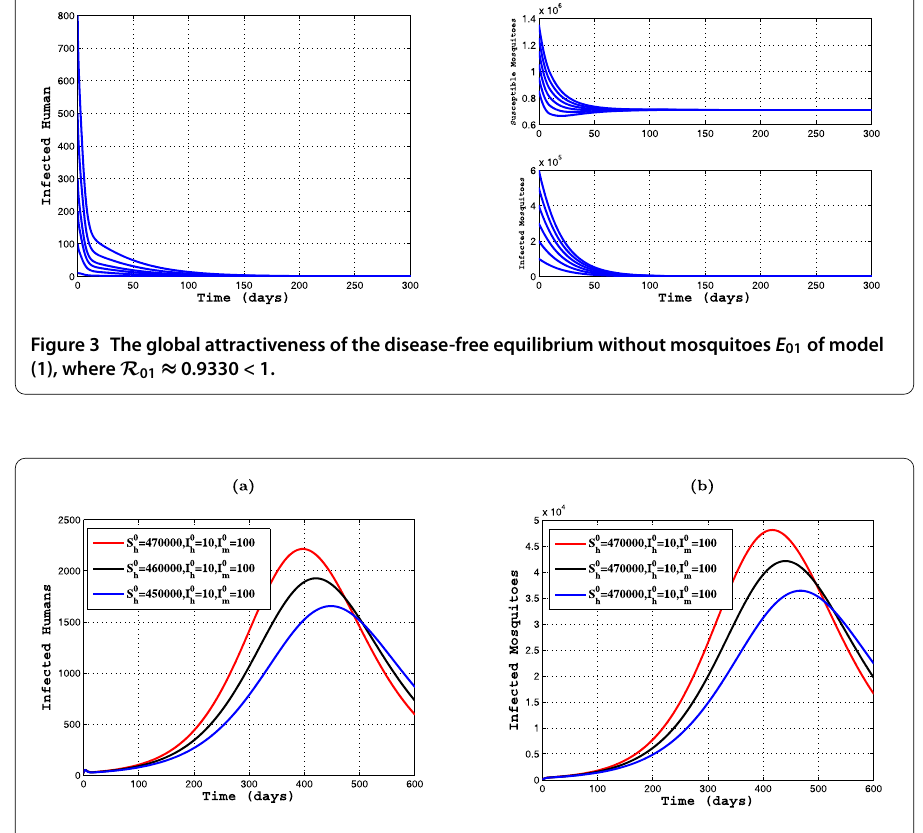
Figure 4 The global attractiveness of the disease-free equilibrium with mosquitoes E 02 of model (1), ≈ 0.4591 < where R 01 ≈ 5.9336 > 1 and R ∗ 02